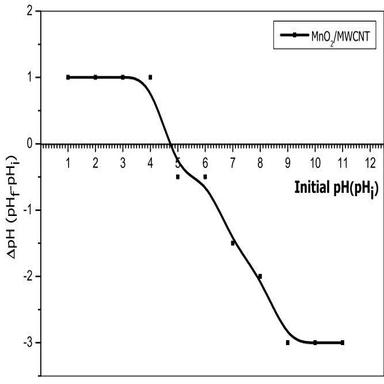
Determination of pHZPC for the mesoporous (MnO2/MWCNT).